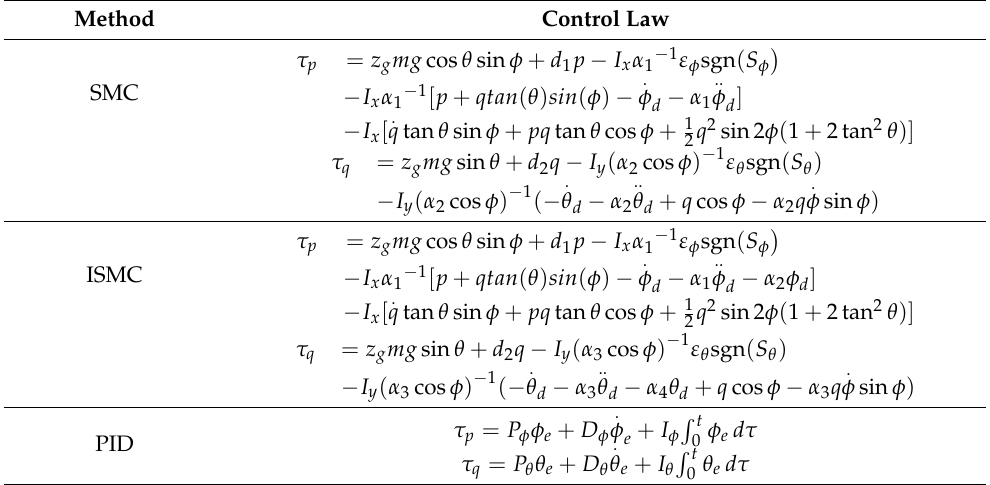
Figure 7. Simulink model. Table 2. Controller for three attitude ‐ control algorithms.